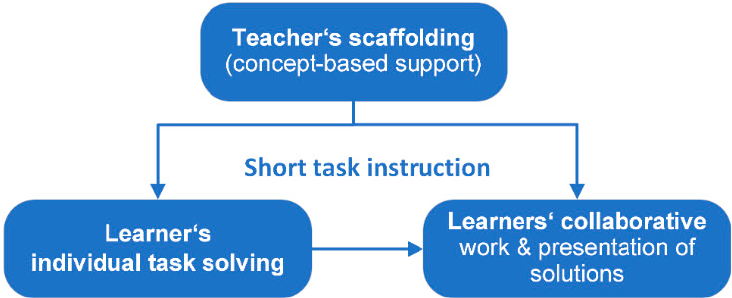
Figure 8. The scaffolding process in the context of the Bebras Challenge (adapted from [17]: Figure 2, page 6). page 6).